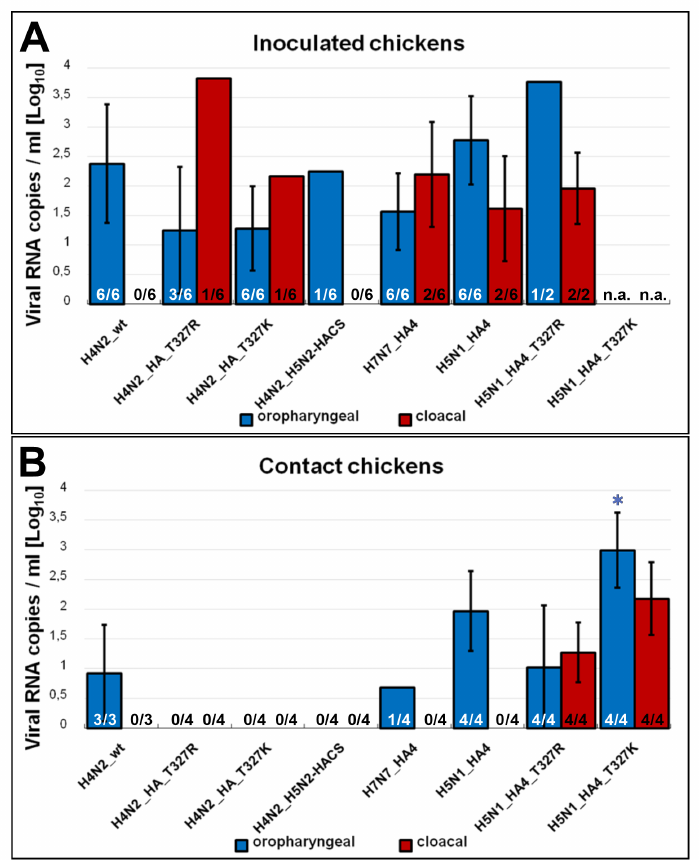
Figure 5. Virus excretion from oropharyngeal and cloacal swabs of inoculated and sentinel chickens. Virus excretion in oropharyngeal and cloacal swabs in inoculated ( A ) and contact ( B ) birds was determined by RT-qPCR targeting the M gene. The averages ± standard deviation of viral RNA copies / ml and number of positive birds / total examined are shown. Samples were collected at 4 dpi from all surviving birds. n.a. = not applicable because all birds inoculated with H4N2_T 327 K died at 2